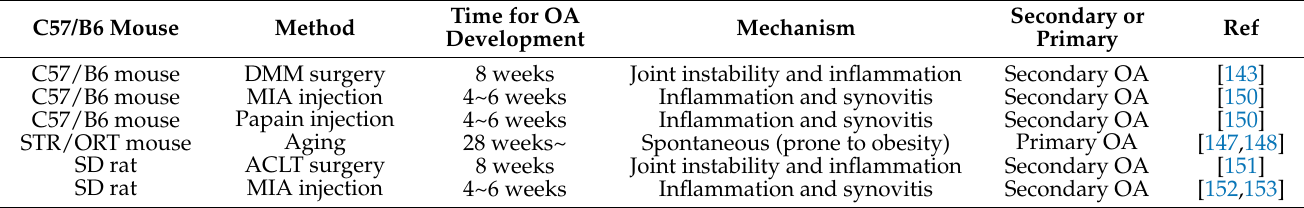
Table 2. List of experimental osteoarthritis animal models used in this